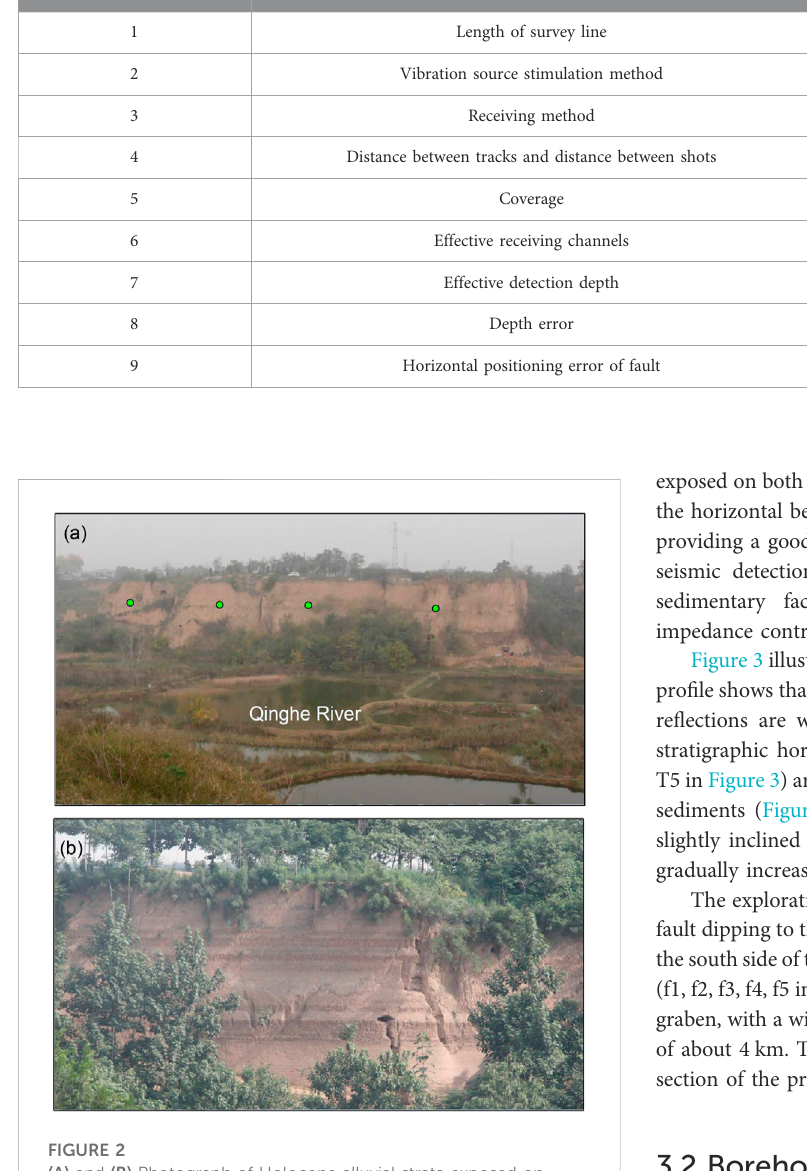
FIGURE 2 (A) and (B) Photograph of Holocene alluvial strata exposed on both banks of the Qinghe river. The small green dot indicates the location of the tan paleosoil